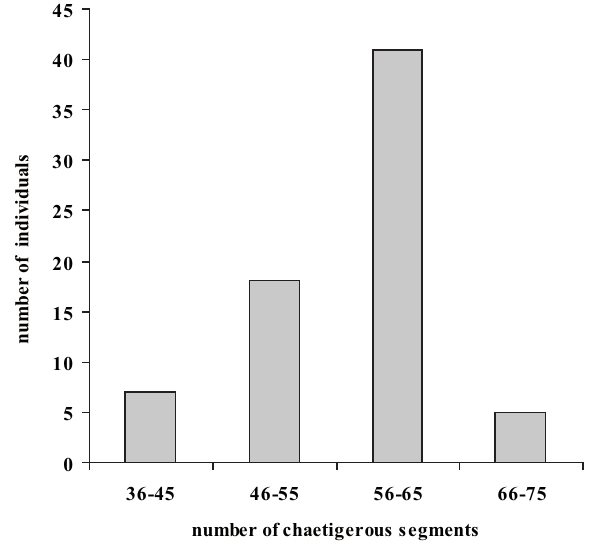
Fig . 2. – Histogram in which breaking points are ranked (n =